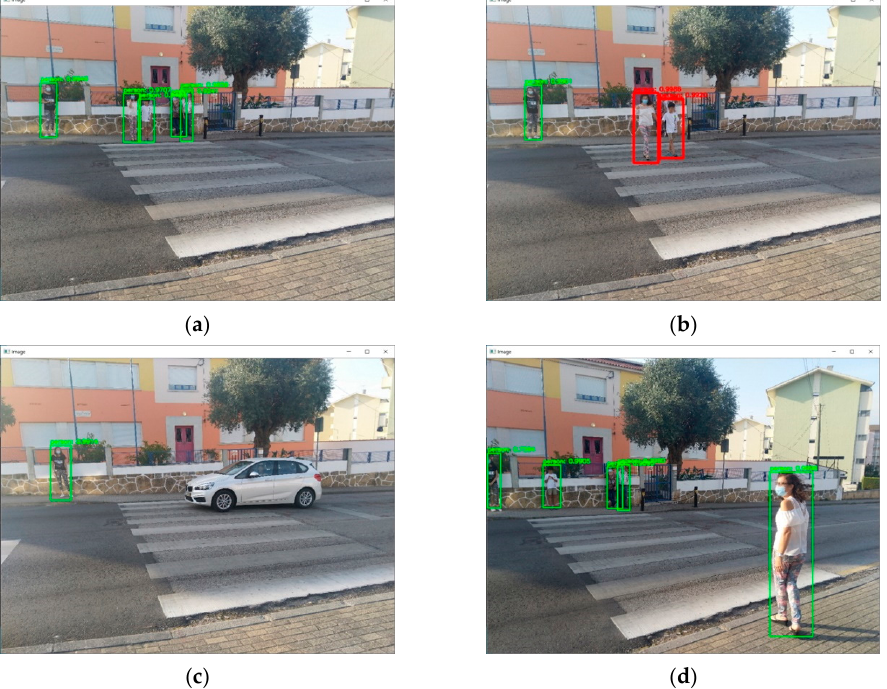
Figure 10. Test for scenario with one ROI: ( a ) all pedestrians out of the crosswalk; ( b ) pedestrians on the crosswalk and facing the camera; ( c ) pedestrians out of the crosswalk and a car passing over the crosswalk, and ( d ) pedestrians on both sides and out of